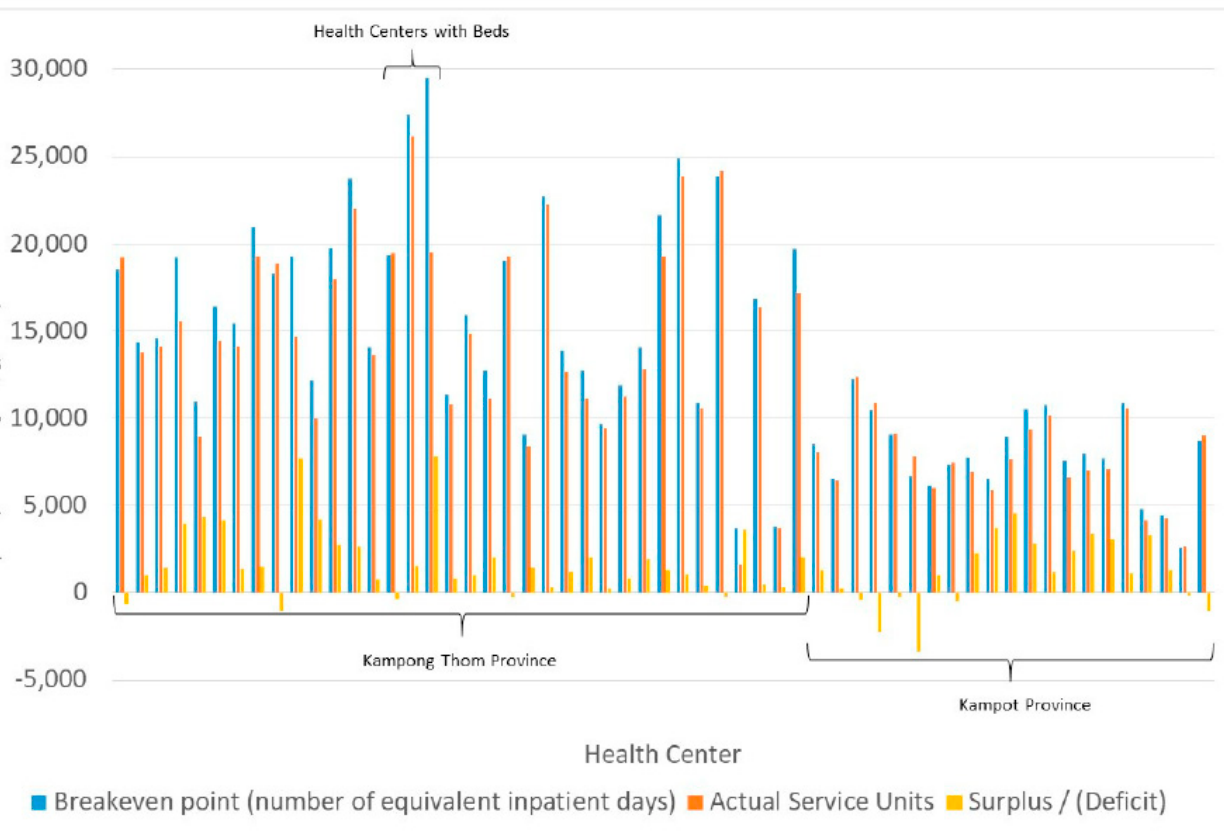
Figure 5. Break-even point, actual service units, and surplus/deficit. Source: own.